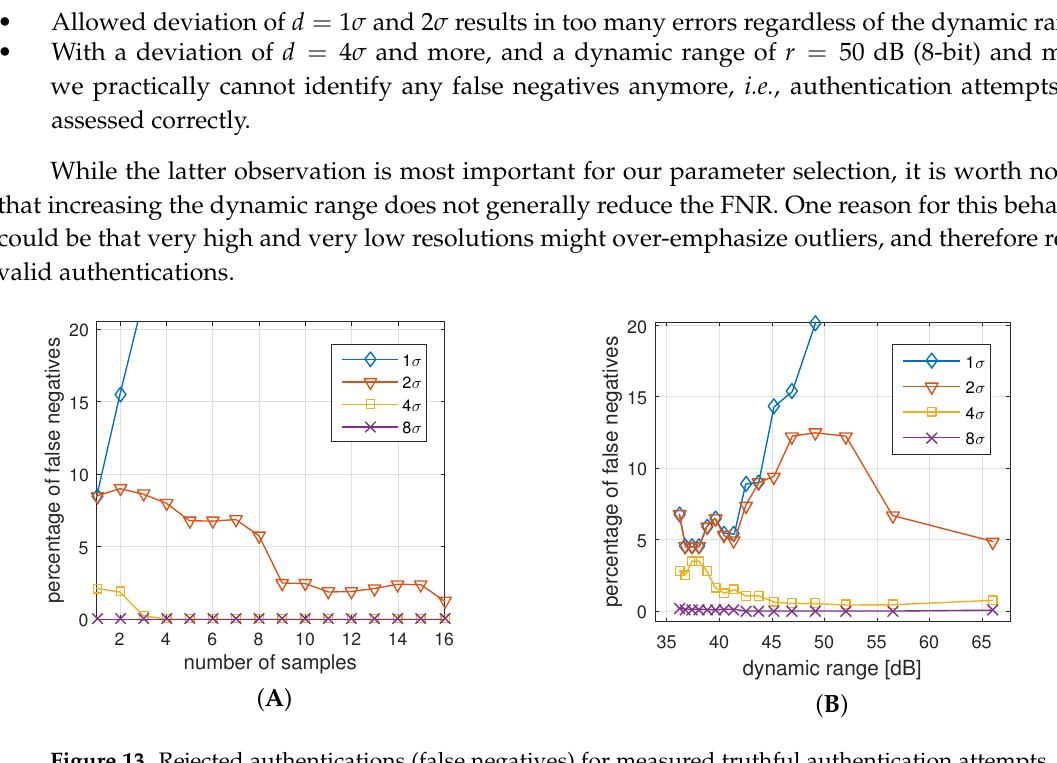
Figure 13. Rejected authentications (false negatives) for measured truthful authentication attempts, ( A ) for different number of samples; and ( B ) for different dynamic